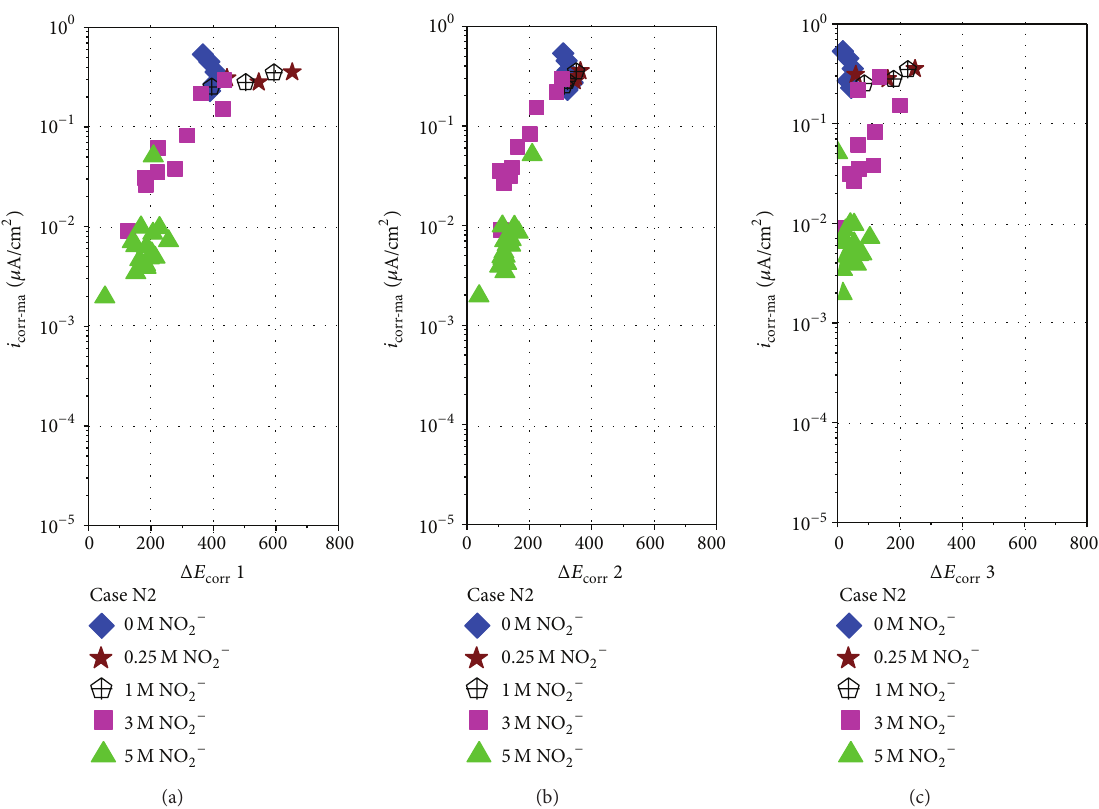
Figure 6: Effect of nitrite concentrations on the (a) relationships between Δ𝐸 Δ𝐸 2 and macrocell current density, and (c) relationships between Δ𝐸 corr